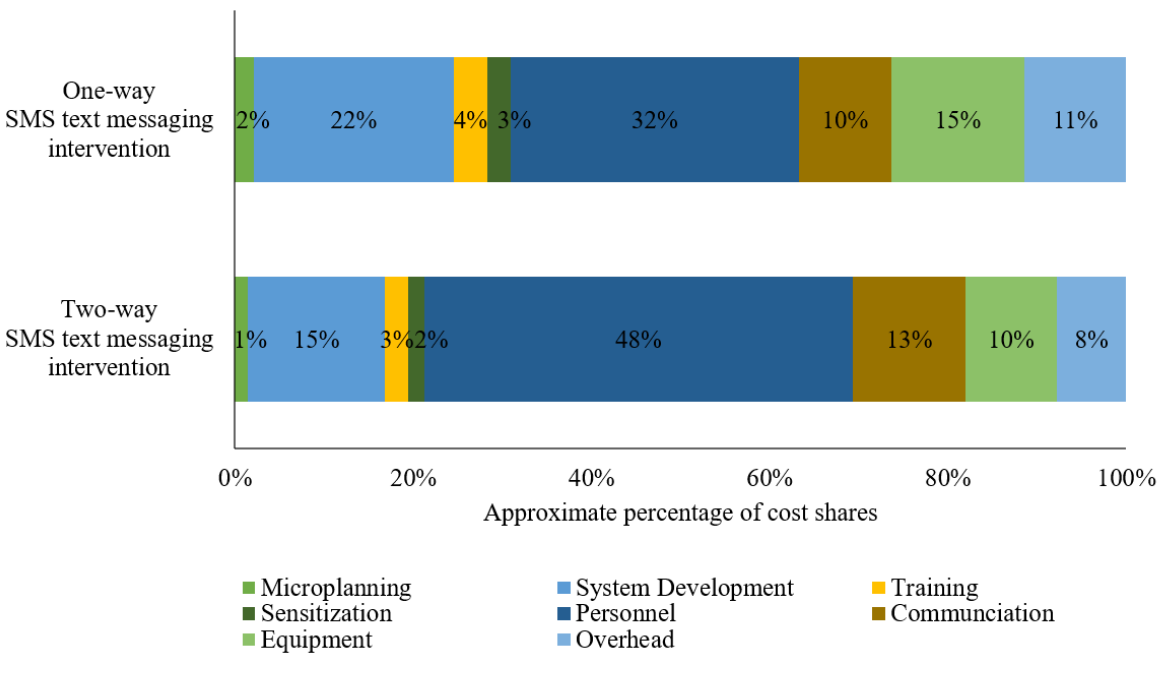
Figure 5. Cost shares for variable input categories